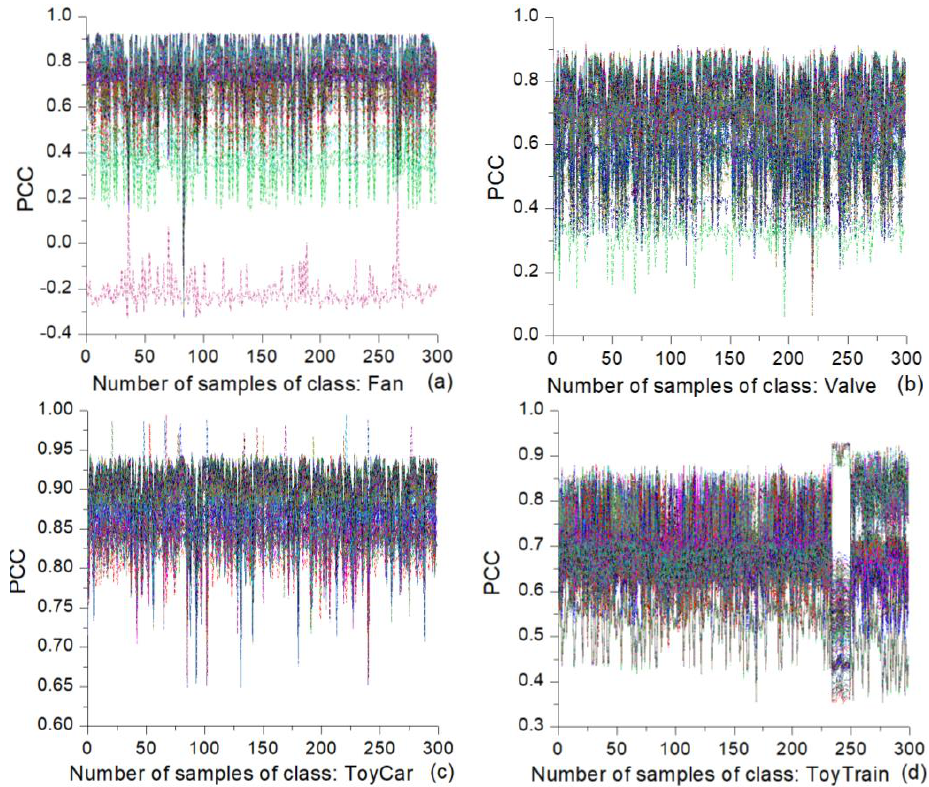
Figure 9. Line plots of intraclass PCC similarity values for individual samples from the extracted dataset: ( a ) fan, ( b ) valve, ( c ) toy – car, and ( d ) toy – train (300 lines in each plot). dataset: ( a ) fan, ( b ) valve, ( c ) toy–car, and ( d ) toy–train (300 lines in each